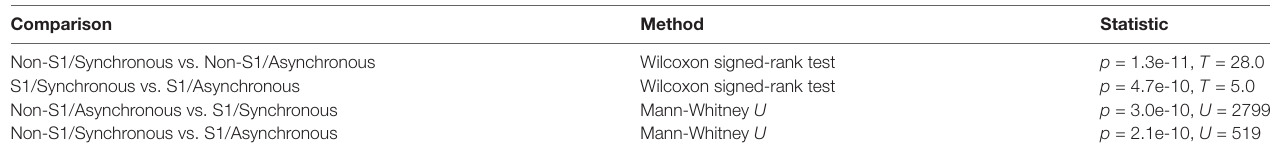
TABLE 2 | Statistical comparison of the decoding performance in different EEG